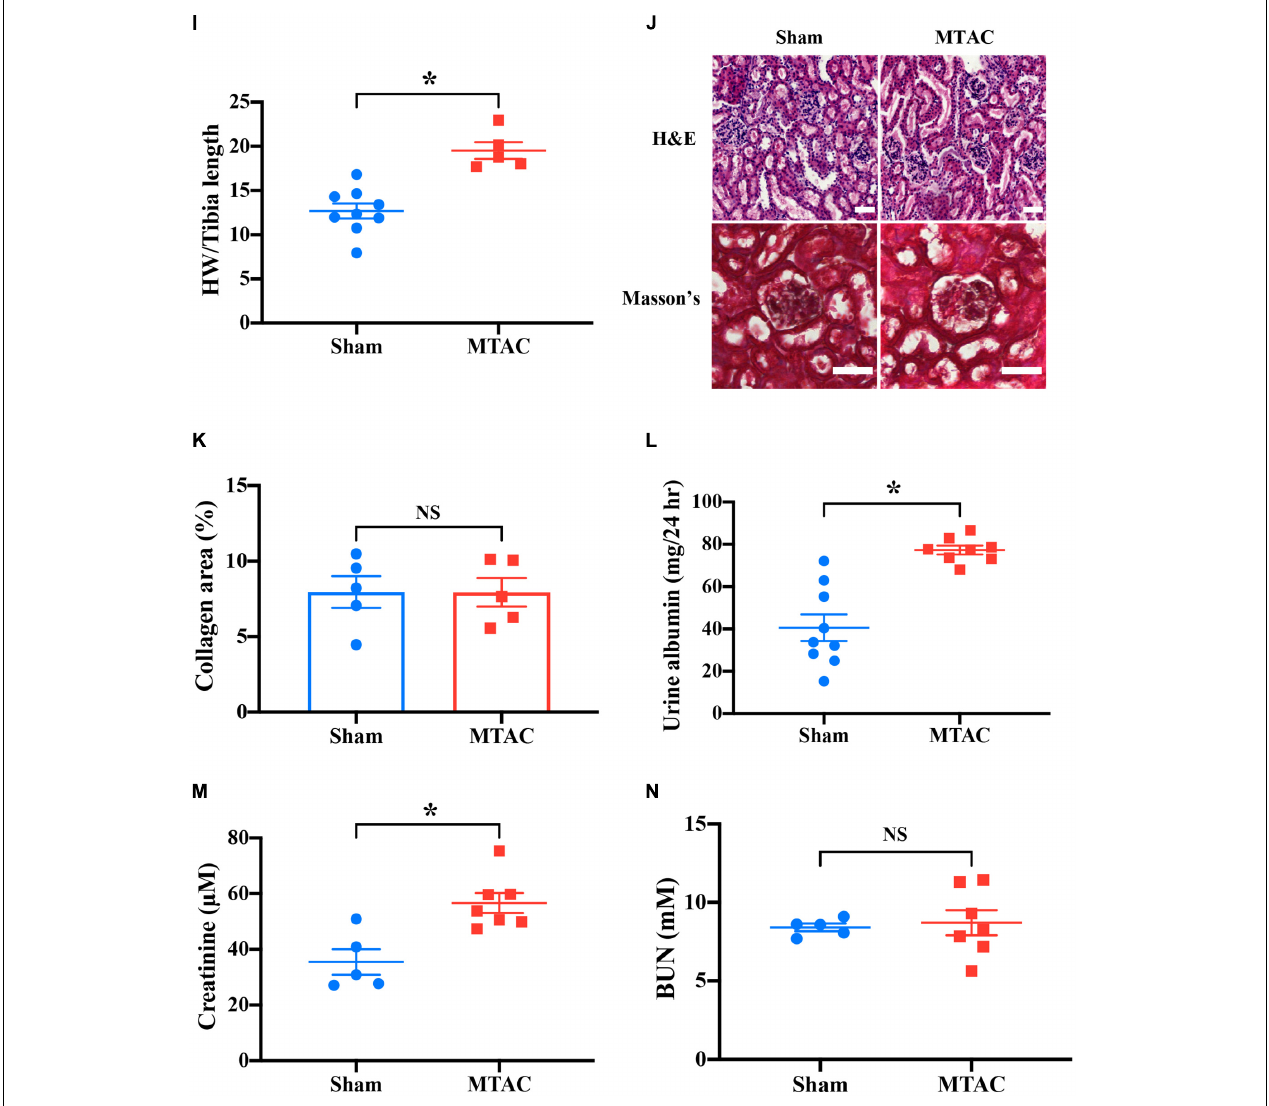
FIGURE 5 | Pressure overload-induced heart failure induces renal dysfunction. (A) Overview of minimally invasive transverse aortic constriction (MTAC) protocol. (B) Protocol of echocardiography measurement and termination in the MTAC mouse model. The mice underwent the MTAC procedure, and cardiac function was measured by echocardiography at 0, 1, 4, 6, and 8 weeks. After 8 weeks, the mice were euthanized for further study. (C) Representative echocardiographic images of mice in the sham group and MTAC group in M-mode. The left ventricular inner diameter significantly increased in the MTAC group. LVEF (D) and FS (E) decreased in the MTAC group compared with the sham group beginning at 4 weeks ( n = 8 in sham group, n = 6 in MTAC group). LVIDD (F) and LVIDS (G) in the MTAC group increased at 6 weeks for LVIDD and 4 weeks for LVIDS ( n = 8 in sham group, n = 6 in MTAC group). (H) Plasma BNP levels increased in the MTAC group compared with the sham group ( n = 5 in sham group, n = 8 in MTAC group). (I) The heart weight-to-tibia length ratio was higher in the MTAC group than in the sham group ( n = 9 in sham group, n = 5 in MTAC group). (J) Representative images of H&E staining and Masson’s trichrome between the two groups ( n = 5 mice per group). Scale bar = 50 µ m. (K) Percentage of collagen area in Masson’s trichrome kidney section ( n = 5 mice per group). No significant difference was found between the two groups. (L) Twenty-four-hour urine albumin was elevated significantly in MTAC group ( n = 9 in sham group, n = 8 in MTAC group). (M) Creatinine levels increased significantly in the MTAC group compared with the sham group ( n = 5 in sham group, n = 7 in MTAC group). (N) BUN levels were not significantly different between the MTAC and sham groups ( n = 5 in sham group, n = 8 in MTAC group). * P < 0.05. NS, not significant; MTAC, minimally invasive transverse aortic constriction; Echo, echocardiography; LVEF, left ventricular ejection fraction; FS, fraction shortening; LVIDD, left ventricular inner diameter diastole; LVIDS, left ventricular inner diameter systole; BNP, brain sodium peptide; HW, heart weight; BUN, blood urea nitrogen; H&E, hematoxylin-eosin; hr, hour.